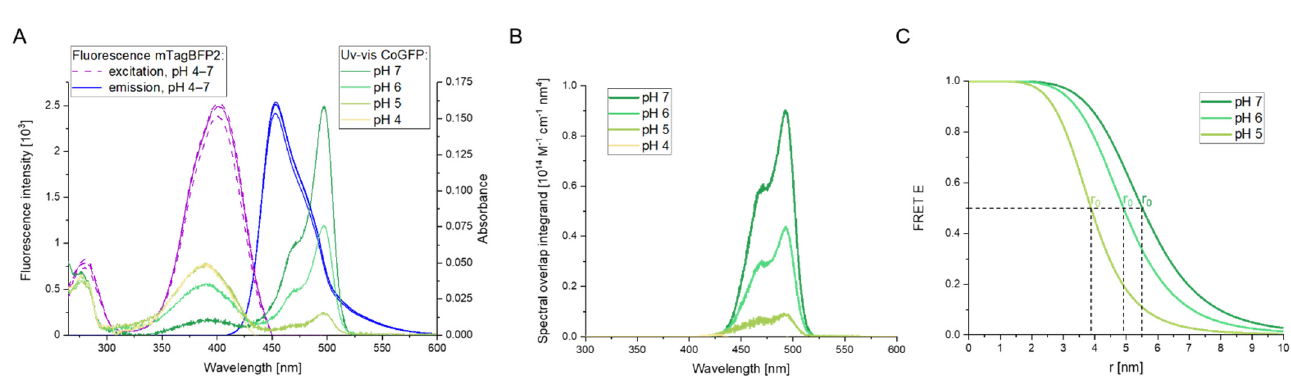
Figure 2. pH-dependent spectral overlap of the FRET donor mTagBFP2 and acceptor CoGFP_V0. ( A ) Excitation (at 455 nm em., purple) and emission (at 400 nm ex., blue) spectra of mTagBFP2 extracted from 3D fluorescence spectra at pH 4 to 7 are plotted together with the UV/Vis absorbance spectra of CoGFP_V0 at pH 4 to 7 (green). The pH-dependent absorbance spectra of CoGFP_V0 overlap with the pH-resistant fluorescence emission of mTagBFP2, indicating a pH-dependent FRET pair. ( B ) The spectral overlap integrand was calculated as product of f D ( λ ), ε A ( λ ) and λ 4 according to Equation (1) with mTagBFP2 as donor and CoGFP_V0 as acceptor for the pH values 7, 6, 5, and 4. The integral of the spectral overlap decreased upon acidification. ( C ) FRET efficiencies E were calculated as a function of the distance r between donor and acceptor according to Equation (3). FRET E was not calculated for pH 4 as no spectral overlap was observed. The Förster radius r 0 is the distance at which FRET E is equal to 50%. According to Equation (2), r 0 was equal to 5.5, 4.9, and 3.9 nm at pH 7, 6, and 5, respectively, for the FRET pair CoGFP_V0-mTagBFP2 due to a decreasing spectral overlap with lower pH